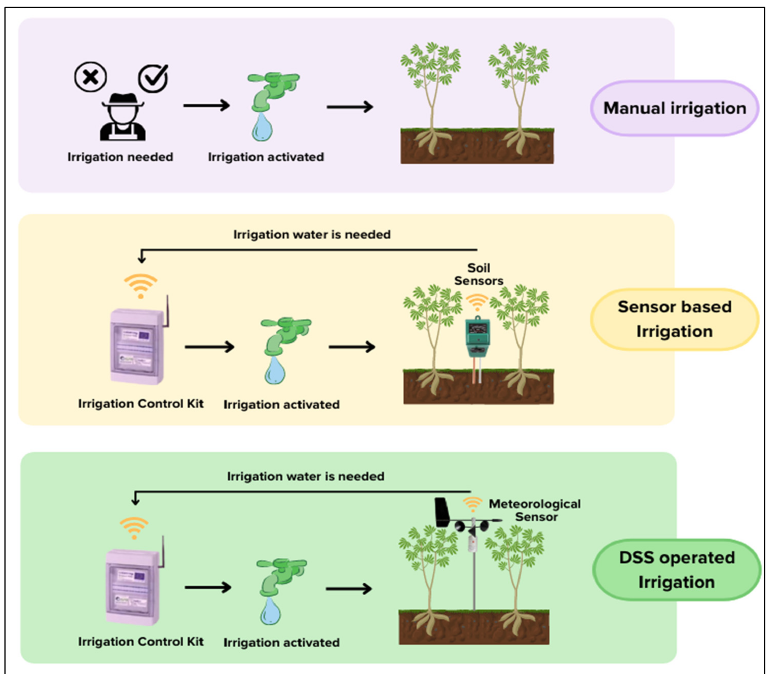
Figure 5. Manual versus smart-sensor-based and decision-support-system-assisted irrigation applications.